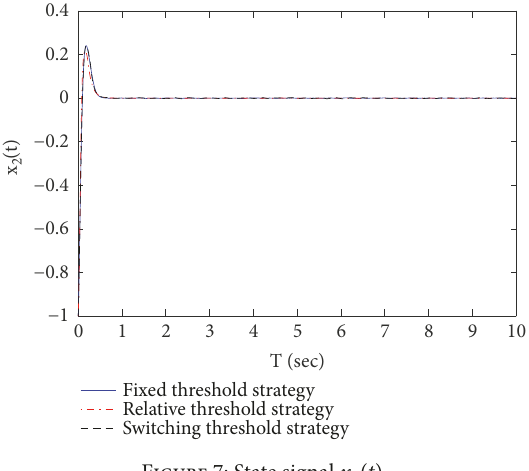
Figure 7: State signal 𝑥 2 (𝑡) .